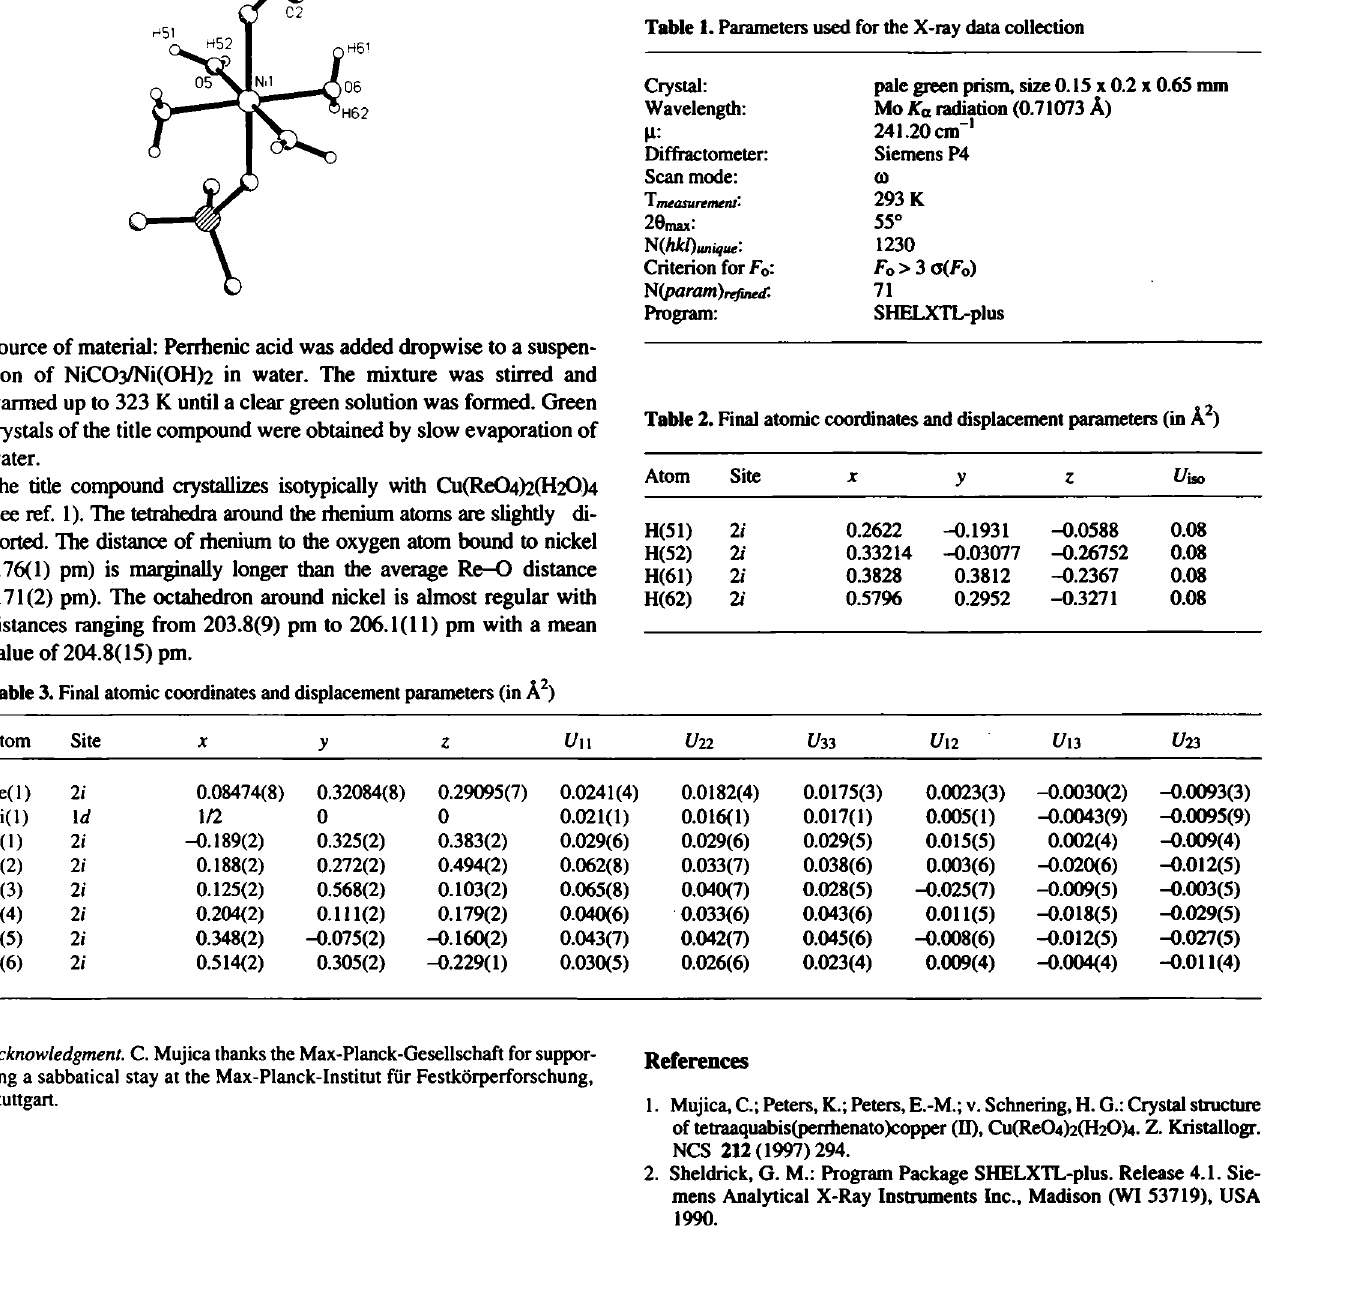
Table 1. Parameters used for the X-ray data collection Crystal: